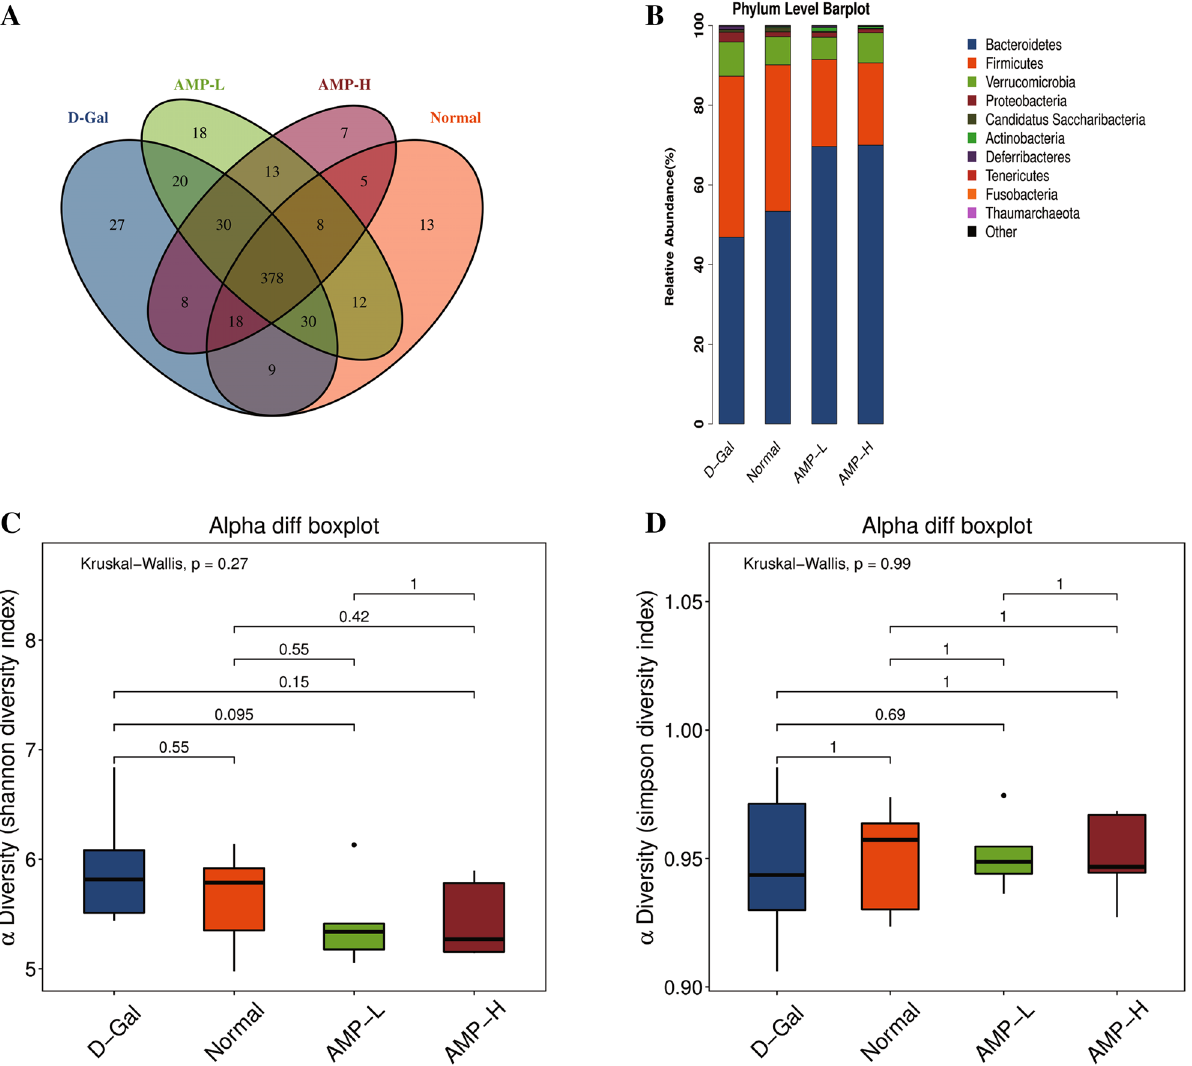
Figure 6. AMP improves D-Gal-induced aging by regulating the intestinal flora of mice. ( A ) Venn diagram; ( B ) Phylum lever barplot. ( C , D ) Alpha diff boxplot. ( E ) Unweighted UniFrac ANOSIM. ( F , G ) Relative abundance and unweighted Unifrac. Data are expressed as the mean ± standard deviation (S.D), n = 10. *p < 0.05 or **p < 0.01 vs. normal group; # p < 0.05 or ## p < 0.01 vs. D-Gal group. OTUs were clustered using UPARSE version 7.1 (http:// drive5. com/ uparse/). The images were generated using R 3.6.3 (https:// www.r- proje ct. org/) and pheatmap package (https:// cran.r- proje ct. org/ web/ packa ges/ pheat